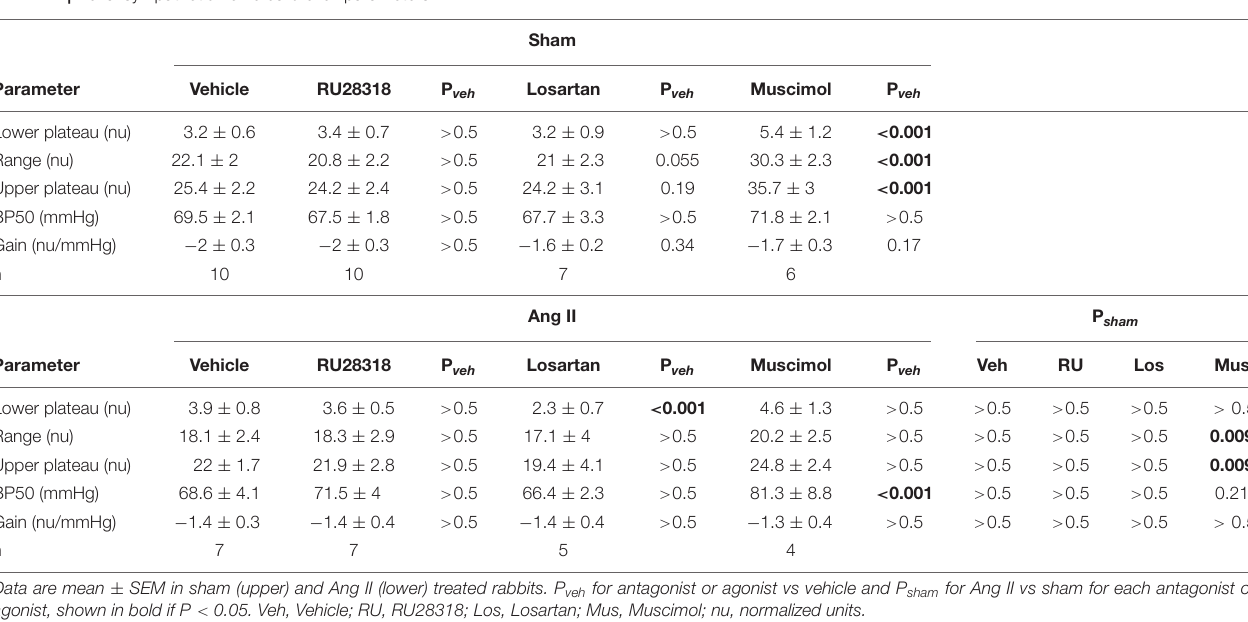
TABLE 2 | Renal sympathetic nerve baroreflex parameters.